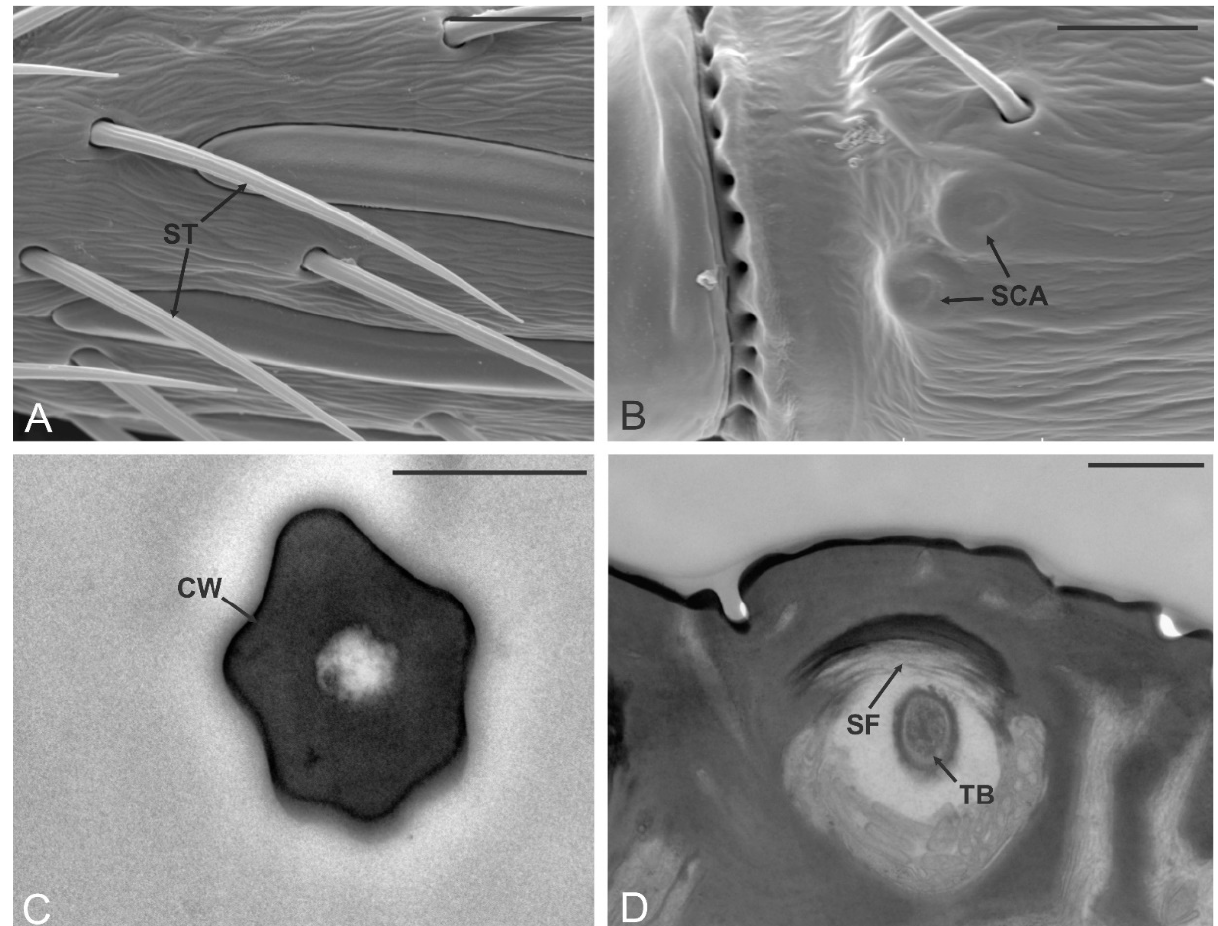
Figure 3. Sensilla trichoidea (ST) and campaniform sensilla. ( A , B ) SEM details of the pedicel (A2) and A4 respectively, where it is possible to observe two sensilla trichoidea (ST) and two sensilla campaniformia (SCA). In ( C ) a TEM cross-section through the cuticular peg of an ST: the thick poreless cuticular wall (CW) delimits an internal lumen without sensory neurons inside. In ( D ) a TEM section through the socket of ST: suspension fibers (SF) and a single sensory neuron giving rise to a tubular body (TB) are depicted. Bar scale: ( A , B ), 10 µm; ( C ), 0.5 µm; ( D ), 1 µm.